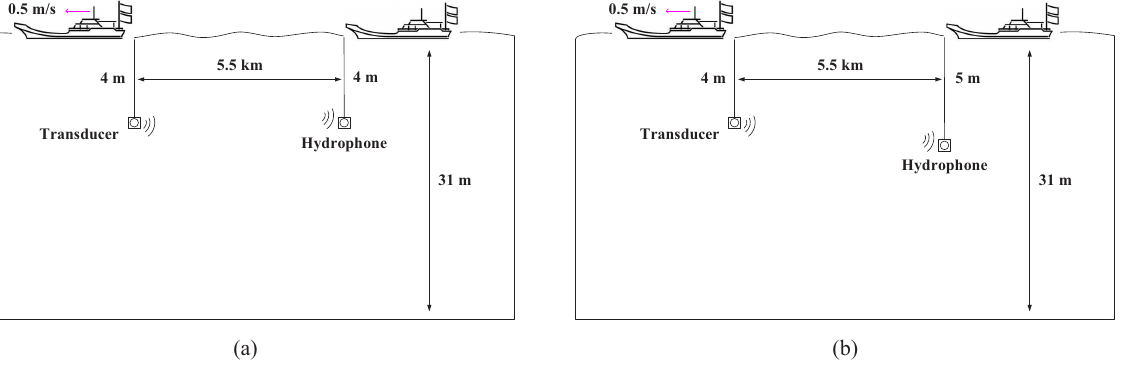
Figure 11. Experimental deployment. ( a ) Yellow Sea 1; ( b ) Yellow Sea